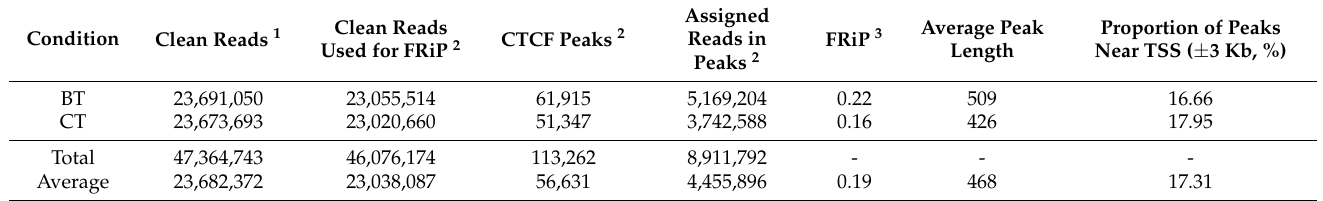
Table 2. Peak calling metrics showing the total number of clean reads used to call peaks and calculate the fraction of reads in peaks (FRiP), number of CTCF peaks (FDR < 0.05), number of assigned reads in peaks, FRiP, an average of peak lengths, and the proportion of peaks near TSS ( ± 3Kb, %).